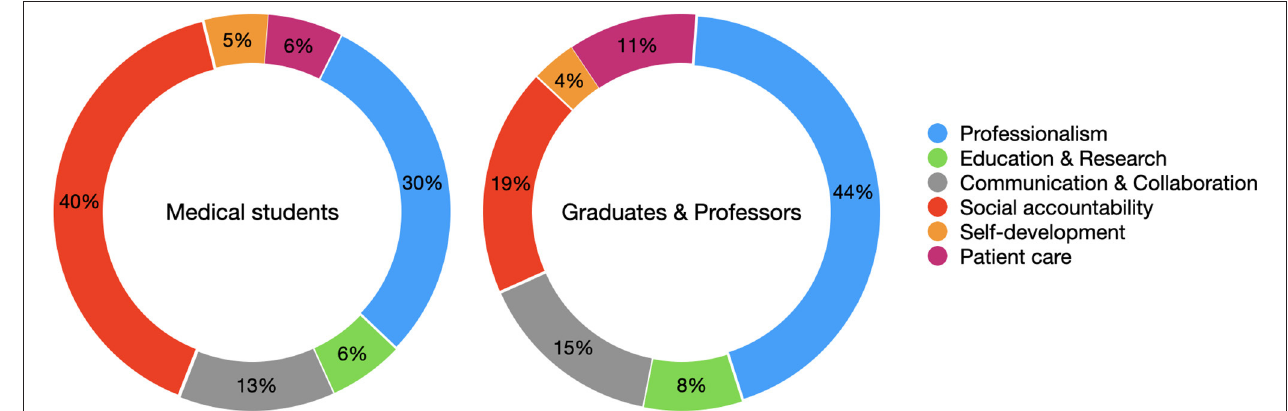
FIGURE 1 | The phase outcome, which is the most important in the pandemic era.